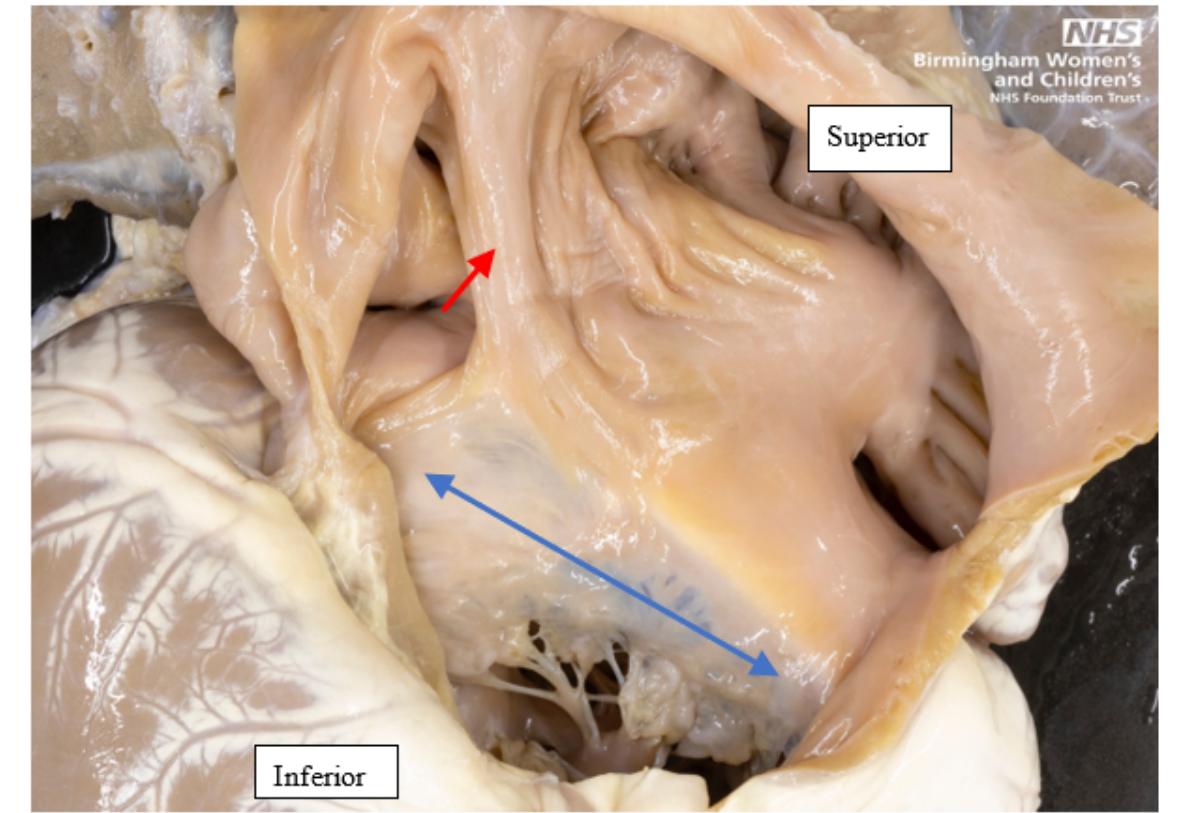
Figure 3. Antero-superior view of the internal aspect of the common atrium and the common AV valve of a heart with left atrial appendage isomerism. The anterior wall of the atrium has been dissected and reflected superiorly and laterally. A septal strand on the posterior wall of the atrium is shown by the red single-headed arrow. The common AV valve, within the common AV junction, is shown by the double headed blue arrow.